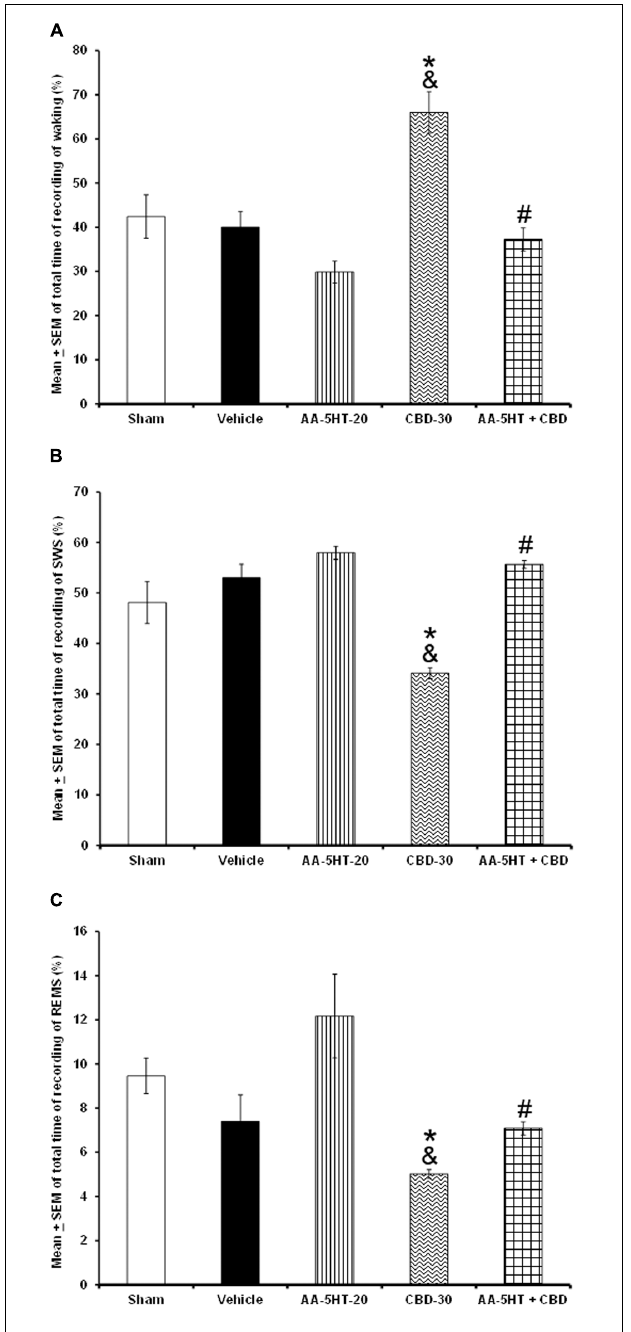
FIGURE 4 | Effects on total time of W, SWS, and REMS after experimental trials administered at the beginning of the lights-on period: Sham, vehicle, AA-5-HT (20 mg/Kg; i.p.), cannabidiol (CBD, 30 mg/Kg; i.p.) or AA-5-HT (20 mg/Kg; i.p.) and 15 min CBD (30 mg/Kg; i.p.). AA-5-HT caused no statistical difference in waking, SWS and REMS. However, CBD (30 mg/Kg; i.p.) enhanced alertness and decreased SWS as well as REMS. Interestingly, AA-5-HT administered 15min before the injection of CBD blocked the increase in W as well as the enhancement in SWS and partially REMS caused by CBD ( A–C , respectively; Mean ± SEM ∗ vs. Sham/Vehicle, P < 0.05; & vs. AA-5-HT-20, P < 0.05; # vs. CBD-30, P < 0.05). Abbreviations: Cannabidiol 30 mg/Kg, i.p. (CBD-30), AA-5-HT-20 mg/Kg (AA-5-HT-20).